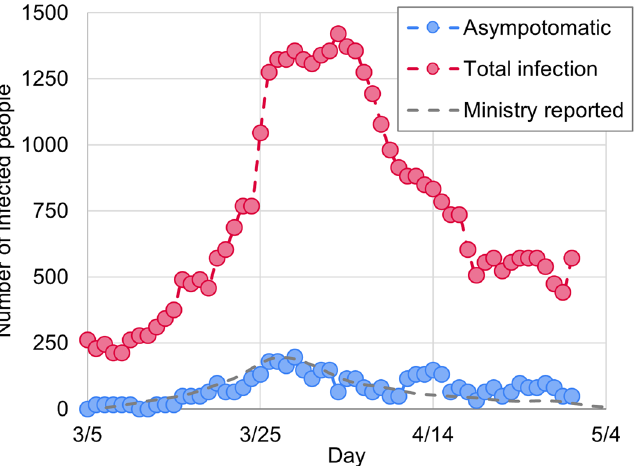
Figure 1. Epidemic curves obtained by calculation and values reported by the Japanese Ministry of Health, Labour, and Welfare. Ministry reported values are taken from Ref. 8